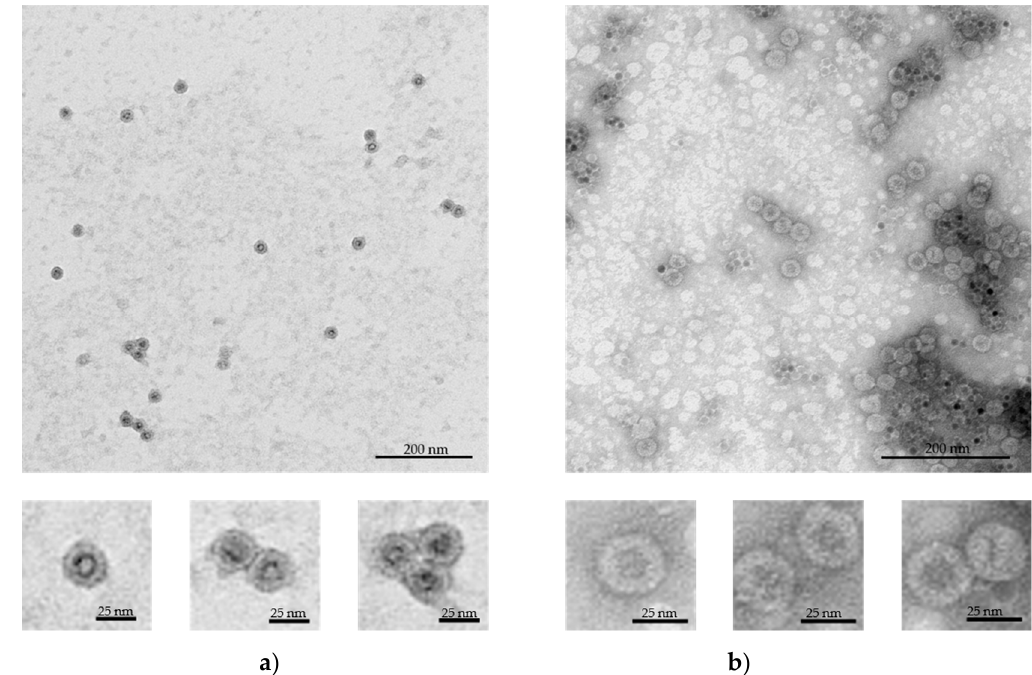
Figure 2. Transmission electron microscopy (TEM) images of the assembled VLPs with magnetic cores, negatively stained with 2% uranyl acetate. a) SPION-DHP-HBc VLPs obtained at 0.2 mg/ml of SPION-DHP and 0.05 mg/ml of HBc; b) SPION-PEG-HBc VLPs obtained at 0.05 mg/ml of SPION-PEG and 0.05 mg/ml of HBcAg.